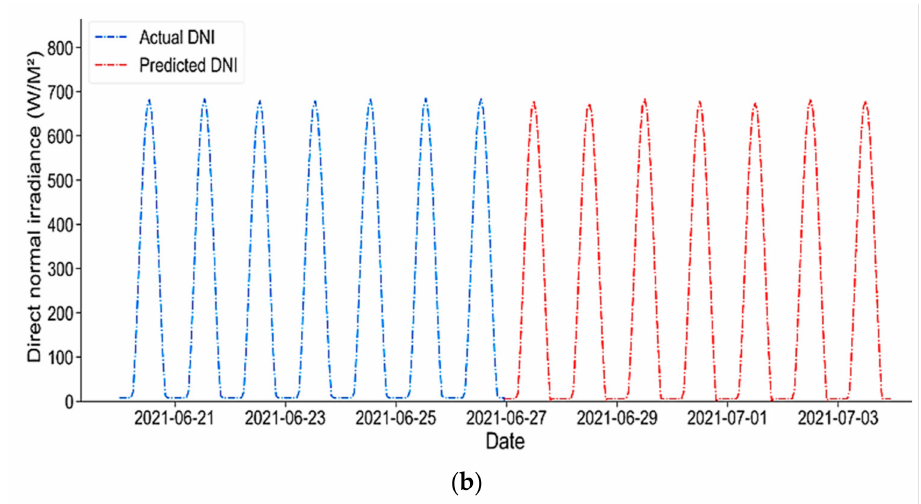
Figure 19. ( a ) The real and predicted values of DNI, which show the fit and performance of the BI-LSTM model; and ( b ) the DNI’s predicted future values for the next 169 h.